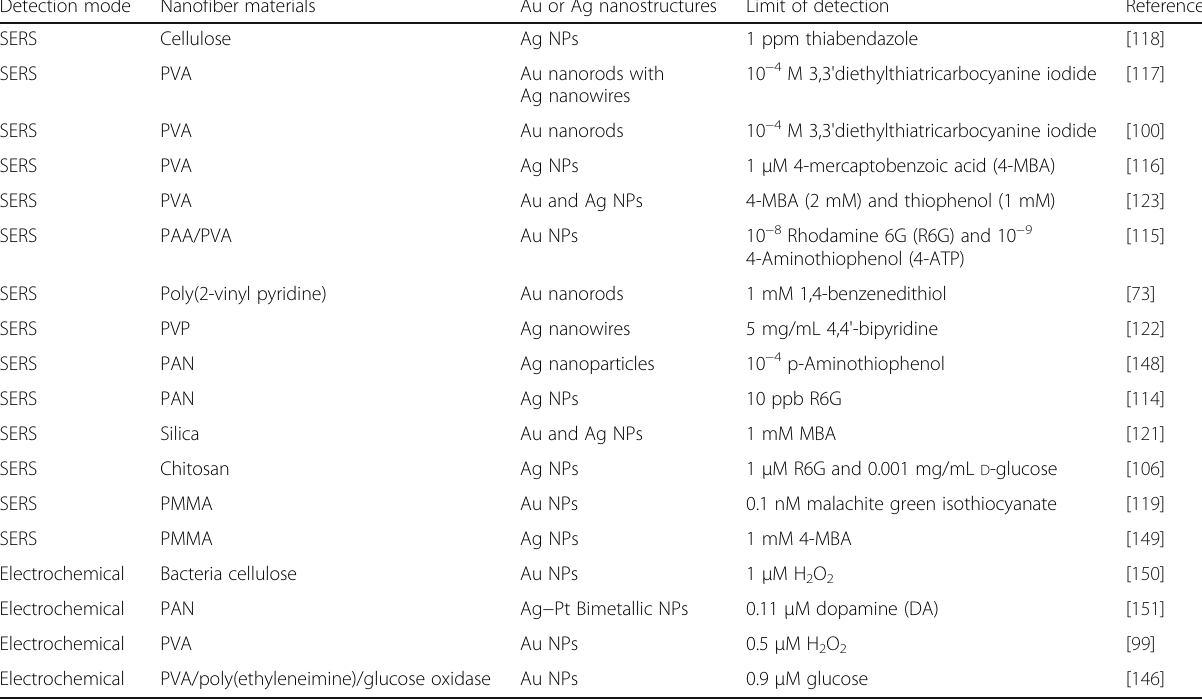
Table 1 Examples of sensing applications of electrospun polymer nanofibers decorated with noble metal nanoparticles Detection